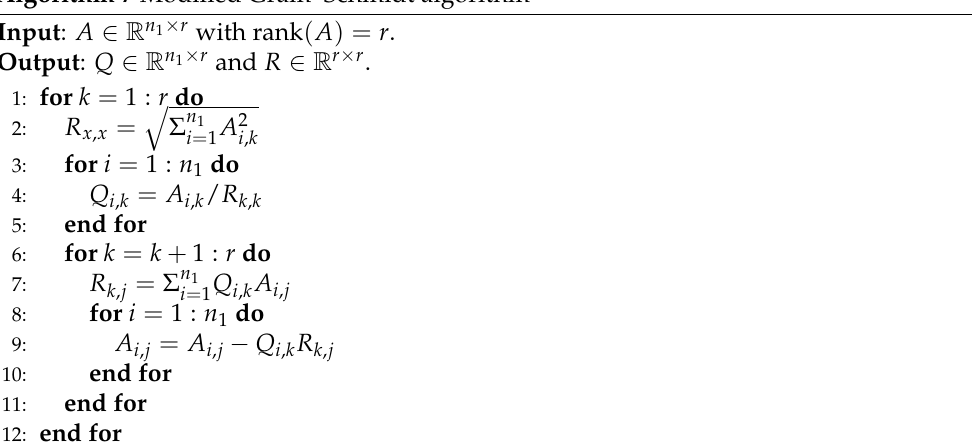
Algorithm 7 Modified Gram–Schmidt algorithm